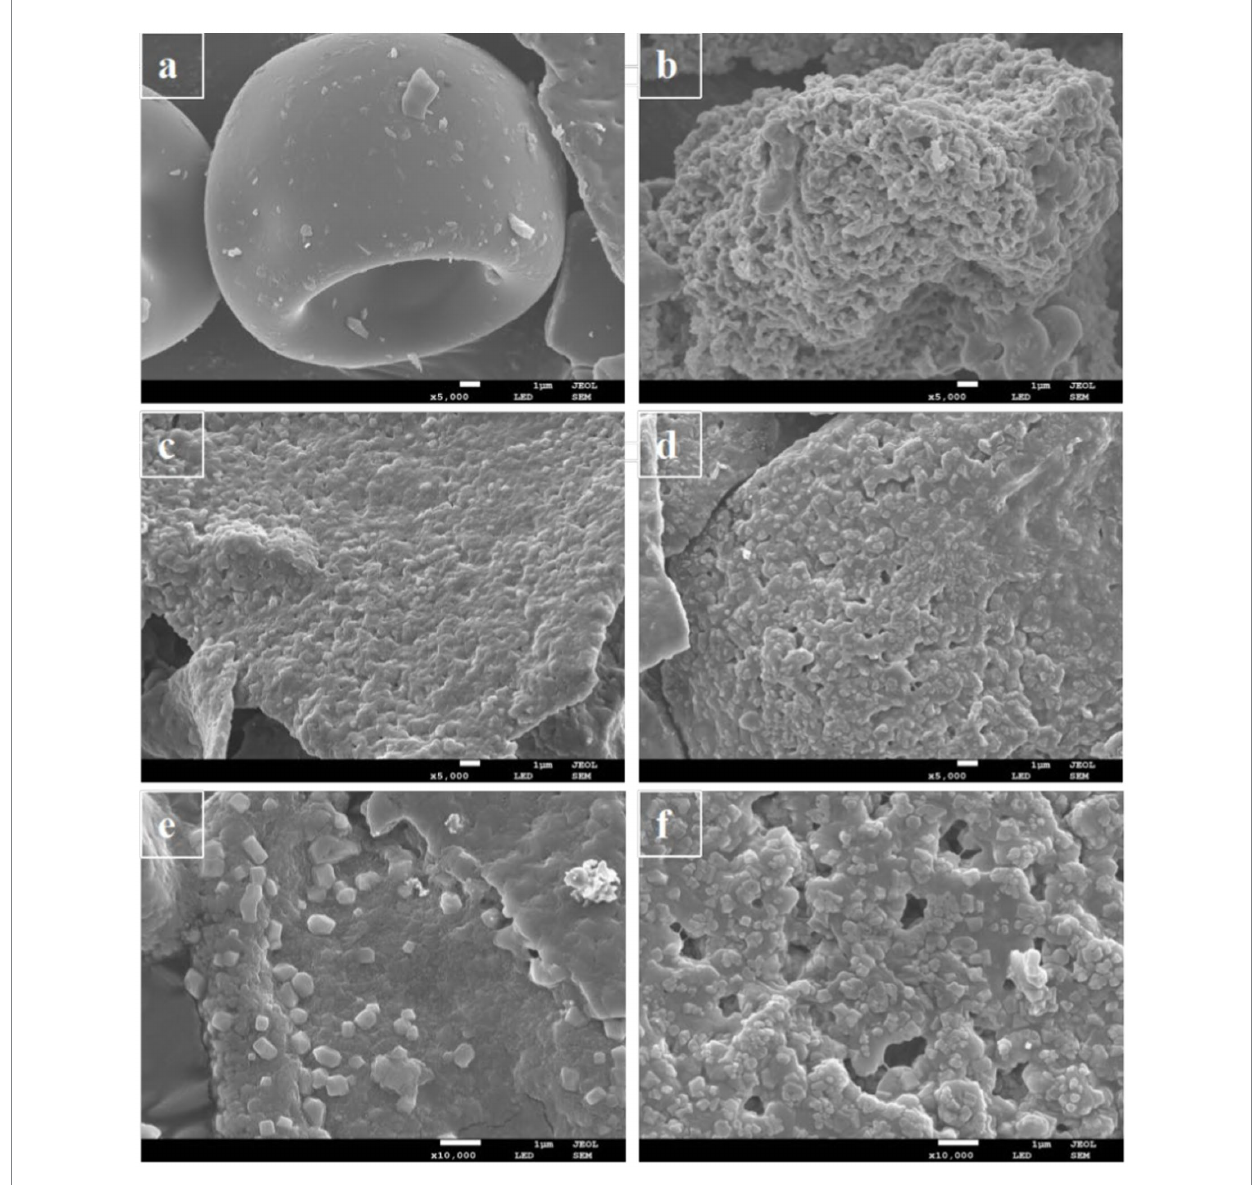
FIGURE 4 SEM micrographs of (A) PC, (B) phlorotannin, (C) PP (1:1)-5,000x, (D) UPP (1:1)-5,000x, (E) PP (1:1)-10,000x, and (F) UPP